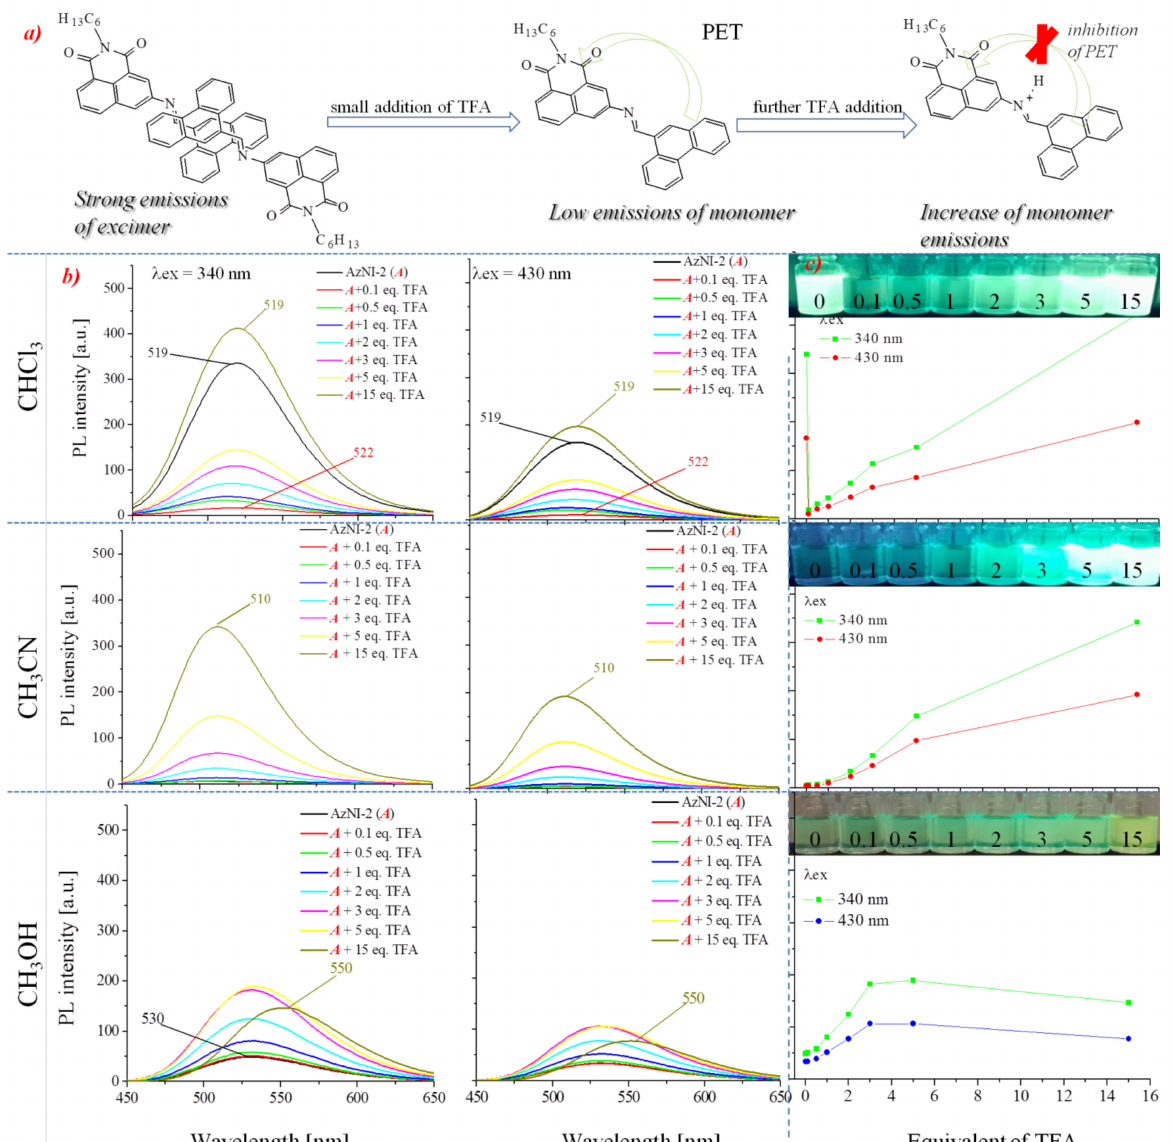
Figure 6. Effect of the TFA on photoluminescence (PL) properties of AzNI-2 in chloroform, acetonitrile, and methanol: ( a ) the proposed mechanism; ( b ) superimposed emission spectra at excitation 340 or 430 nm; ( c ) λ em intensity versus equivalent of TFA. Photographs were taken under λ = 366 nm UV irradiation from a hand-held UV